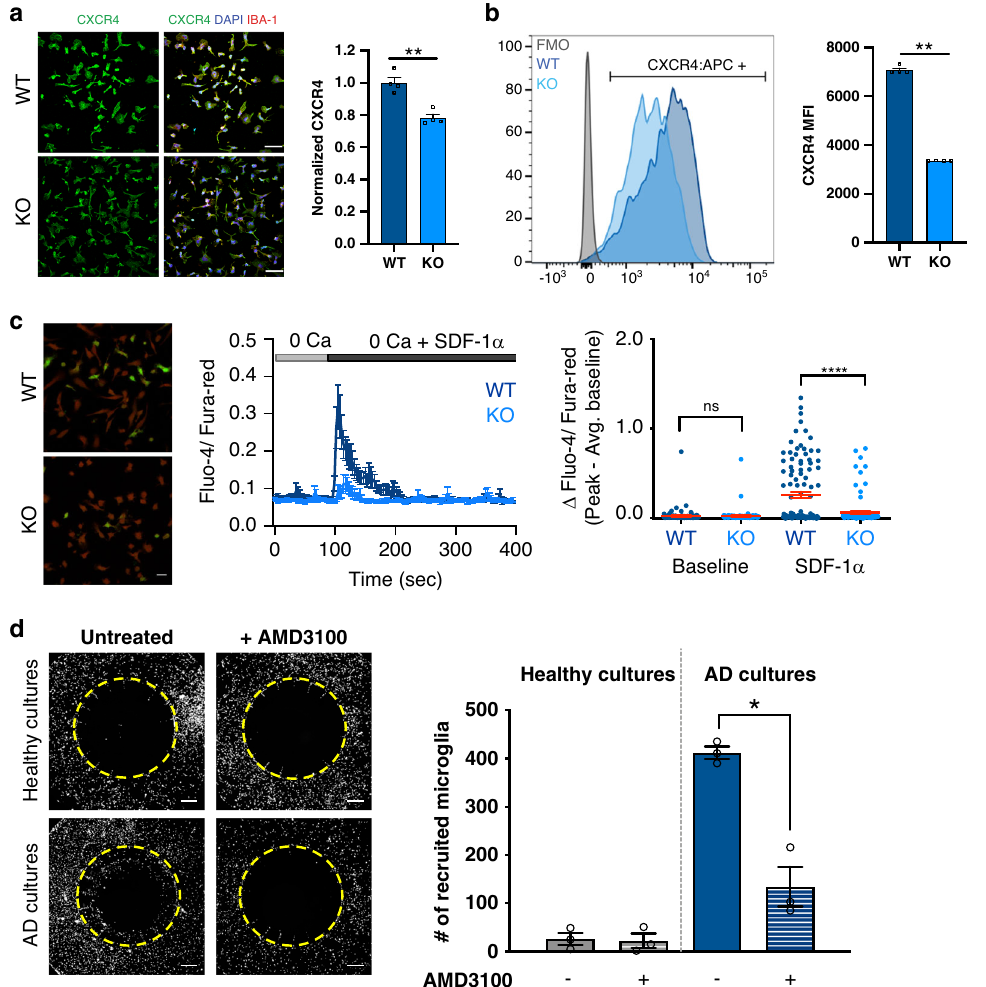
Fig. 5 TREM2 knockout microglia are de fi cient in CXCR4 which is required for migration. a Expression of CXCR4 (green), IBA-1 (red) in in vitro TREM2 isogenic lines. CXCR4 signal was normalized to DAPI (blue) intensity. Scale bar: 40 μ m. In quanti fi cation, darker shades represent TREM2 WT. ( n = 4 independent wells, 4 images per well, Experiment replicated in three independent lines; unpaired t -test p = 0.0015). Data are represented as mean values ± SEM. b Flow cytometry of CXCR4:APC (gated on fl uorescence minus one (FMO) control (gray)) and quanti fi cation of mean fl uorescence intensity (MFI) ( n = 3 independent samples (100,000 events each), unpaired t -test p = 0.0017). Data are represented as mean values ± SEM. Gating strategy in Source data fi le. Reproduced with all three isogenic sets with similar results. c Overlay of maximum intensity projection images over time of Fluo-4 (green) and Fura-Red (red) loaded WT and TREM2 KO cells after activation with SDF-1 α (left panel, Scale bar: 20 μ m). Time-lapse run showing average cytosolic Ca 2 + response to 250 ng/mL SDF-1 α measured by ratiometric Fluo-4 and Fura-Red signal (middle panel, Data are mean ± SEM; n = 51 – 61 cells). Summary of single cell baseline and maximal SDF-1 α induced Ca 2 + elevation in WT and KO microglia (right panel, Data are mean ± SEM, n = 111 – 120 cells, 2 experiments). Y -axis denotes either peak baseline or peak SDF-1 α response subtracted from the average baseline for each cell (**** p < 0.0001, n.s not signi fi cant, as measured by One-way ANOVA; Post-hoc Tukey ’ s multiple comparisons test). d WT microglia were allowed to migrate to 9-week old healthy or beta-amyloid producing (AD) neural/glial cultures plated within the central chamber (white dashed circle). Microglia pseudocolored gray. AMD3100 was used at 10 ng/mL. Scale bar: 50 μ m (unpaired t -test, p = 0.003) Experiment was reproduced in two lines (total n = 5). Data are represented as mean values ±